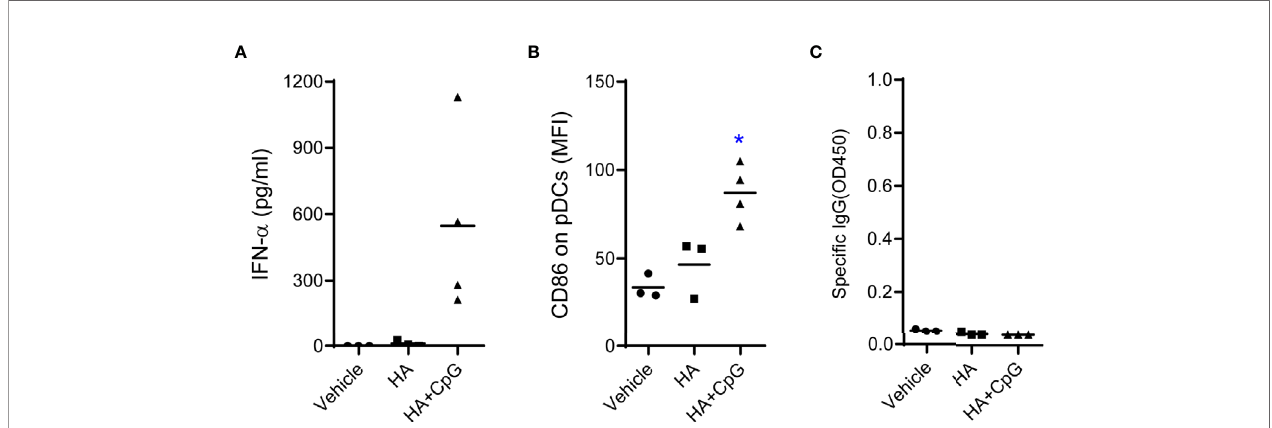
FIGURE 5 | CD40-targeting vaccination is required to induce IgG-response in humanized mice. Humanized mice were treated with PBS control (Vehicle, n=3) or vaccinated with recombinant hemagglutinin protein (HA, n=3, 10 m g/mouse) alone or vaccinated with HA plus CpG-B (n=4) at week0, week3 and week6. (A) IFN-a levels in plasma in plasma at 24 hours post fi rst vaccination was detected by ELISA. (B) The expression of CD86 on pDC (CD4 + CD303 + ) from PBMC at 24 hours post-treatment was detected by FACS. (C) Antigen speci fi c IgG level in the plasma was detected by ELISA. Each dot represents one individual mouse, bars indicate mean. *P < 0.05 by unpaired, two-tailed Student ’ s t-test comparing the two vaccinated